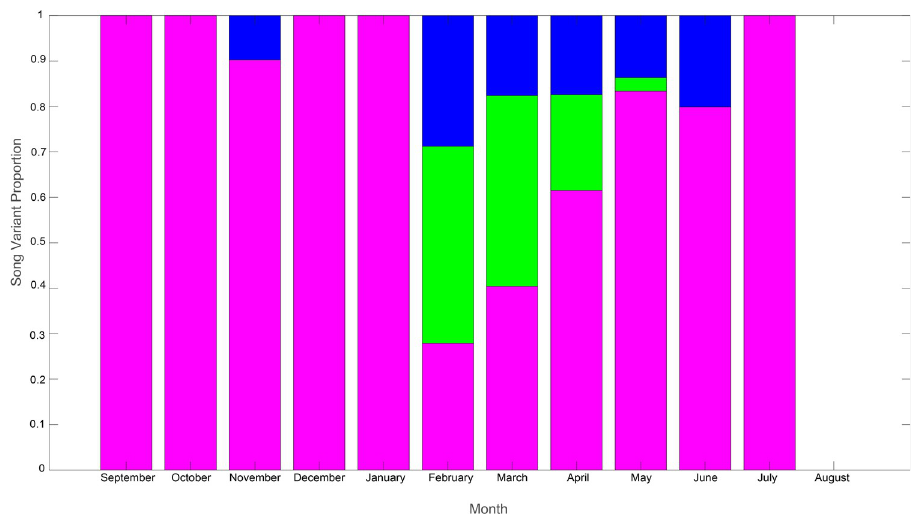
Fig 5. Monthly song variant proportions. Proportion of pulses by month over the course of a year (September to August) belonging to each call variant. Singlets are in pink, doublets in green, and triplets in blue in each stacked bar.